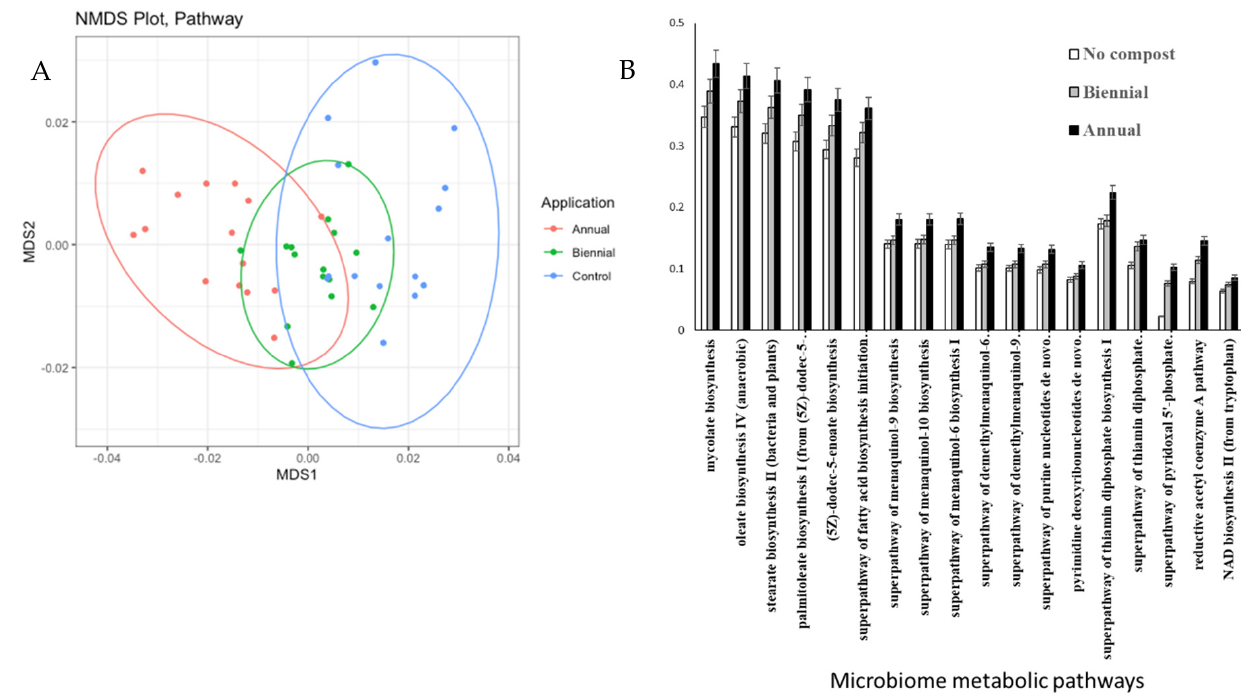
Figure 3. Functional profile of bacterial community based on 16S rRNA marker gene. ( A )–Non-metric multidimensional scaling plot of community functions in soils under different rates of compost application. The analysis is based on Bray–Curtis distances of functional composition of bacterial community evaluated using PICRUSt. ( B )–Pathways those were significantly overrepresented in Biennially and Annually treated soil compared to the untreated soil. Corrected p -values ( q -values) were calculated based on Benjamini–Hochberg FDR multiple test correction. Features with (Welch’s t -test) q -value <0.01 were considered significant and were thus retained. Table 5. Leaf pigmentation and plant photosynthetic efficiency indices as affected by frequency of application of municipal solid waste